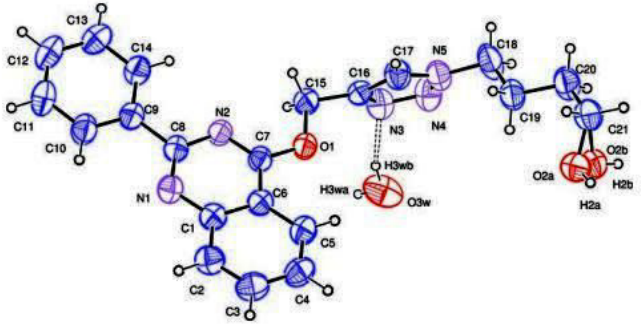
Figure 2. X-ray molecular structure of compound 7c .